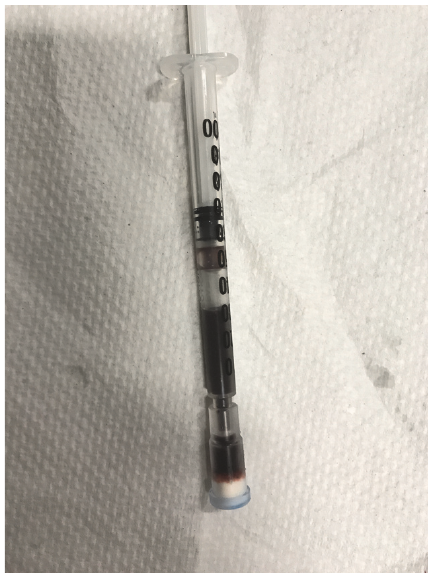
Figure 1: This is an arterial blood sample obtained shortly after admission. It was noted to be significantly darker than expected. Cooximetry was obtained and the methemoglobinemia level was reported as greater than 25%.